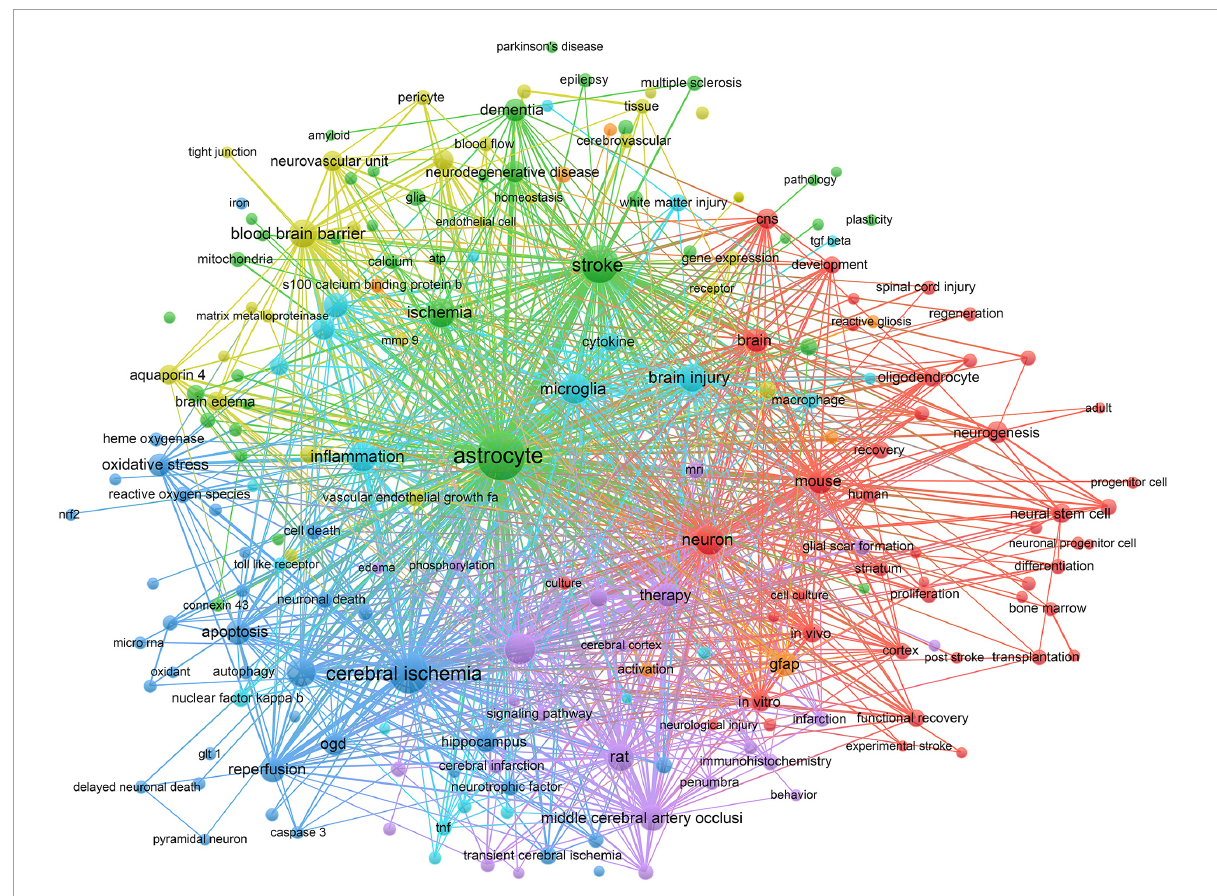
FIGURE5 The occurrence network of the most frequently used authors keywords (frequency >